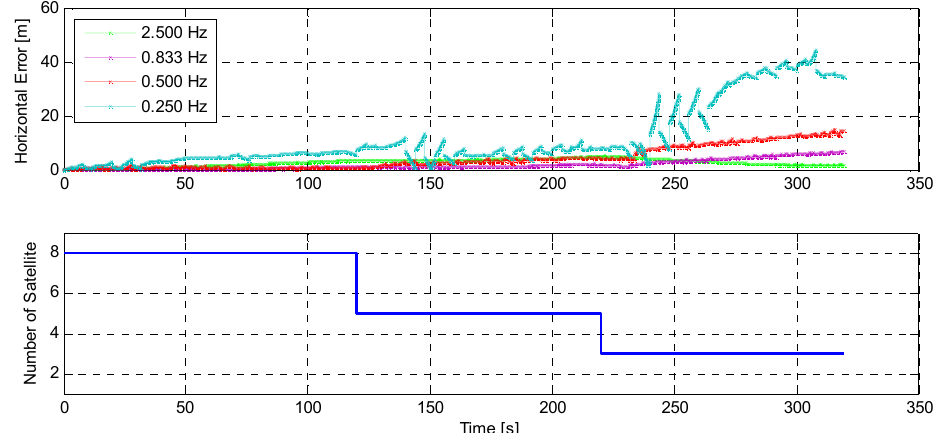
Figure 12. Horizontal positioning error comparison by using different image frame